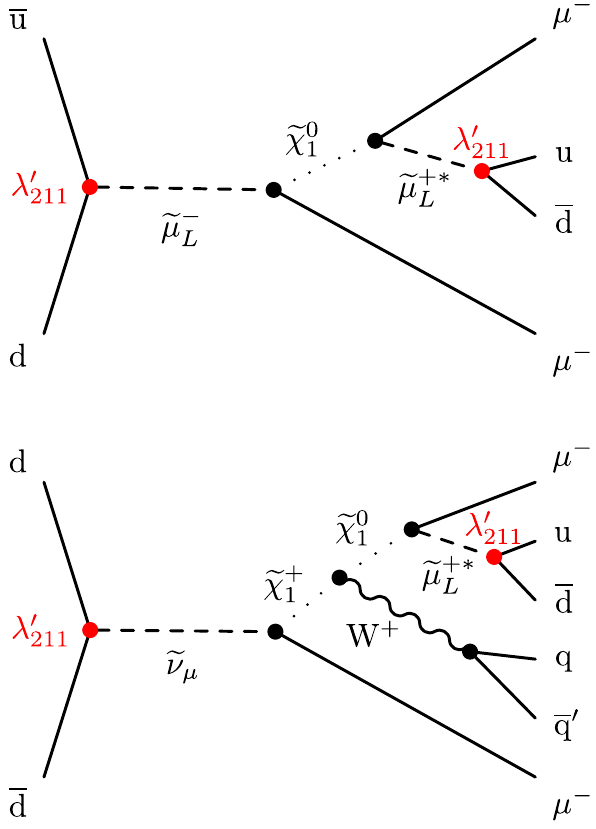
Fig. 1 Signal contributions from a modified cMSSM with λ (cid:3) additional coupling, which are considered as simplified signal models SM1 (upper) and SM2 (lower) in this search. The charge conjugate diagrams are included as